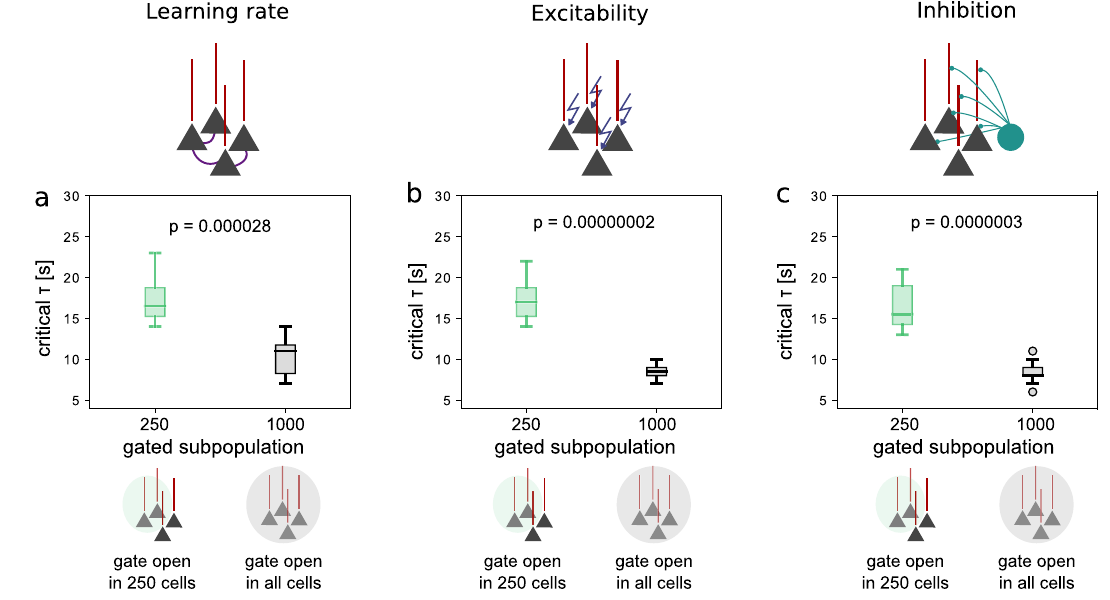
Figure 5. Spatially precise gating of plasticity enables learning while keeping network activity stable. ( a ) Distribution of critical homeostatic time constants for a two-fold increase in the learning rate in a subpopulation of excitatory cells (green) and in the entire network (black). ( b ) Distribution of critical homeostatic time constants for a 15% increase in excitability in a subpopulation of excitatory cells (green) and in the entire network (black). ( c ) Distribution of critical homeostatic time constants for a 20% decrease in inhibition in a subpopulation of excitatory cells (green) and in the entire network (black). The rectangles represent the interquartile range (IQR) between first and third quartiles. The thick horizontal lines represent the medians. The whiskers indicate the lowest and highest values within 1.5xIQR from the first and third quartiles, respectively. The circles denote outliers. p-values were obtained by using the two-sample student’s